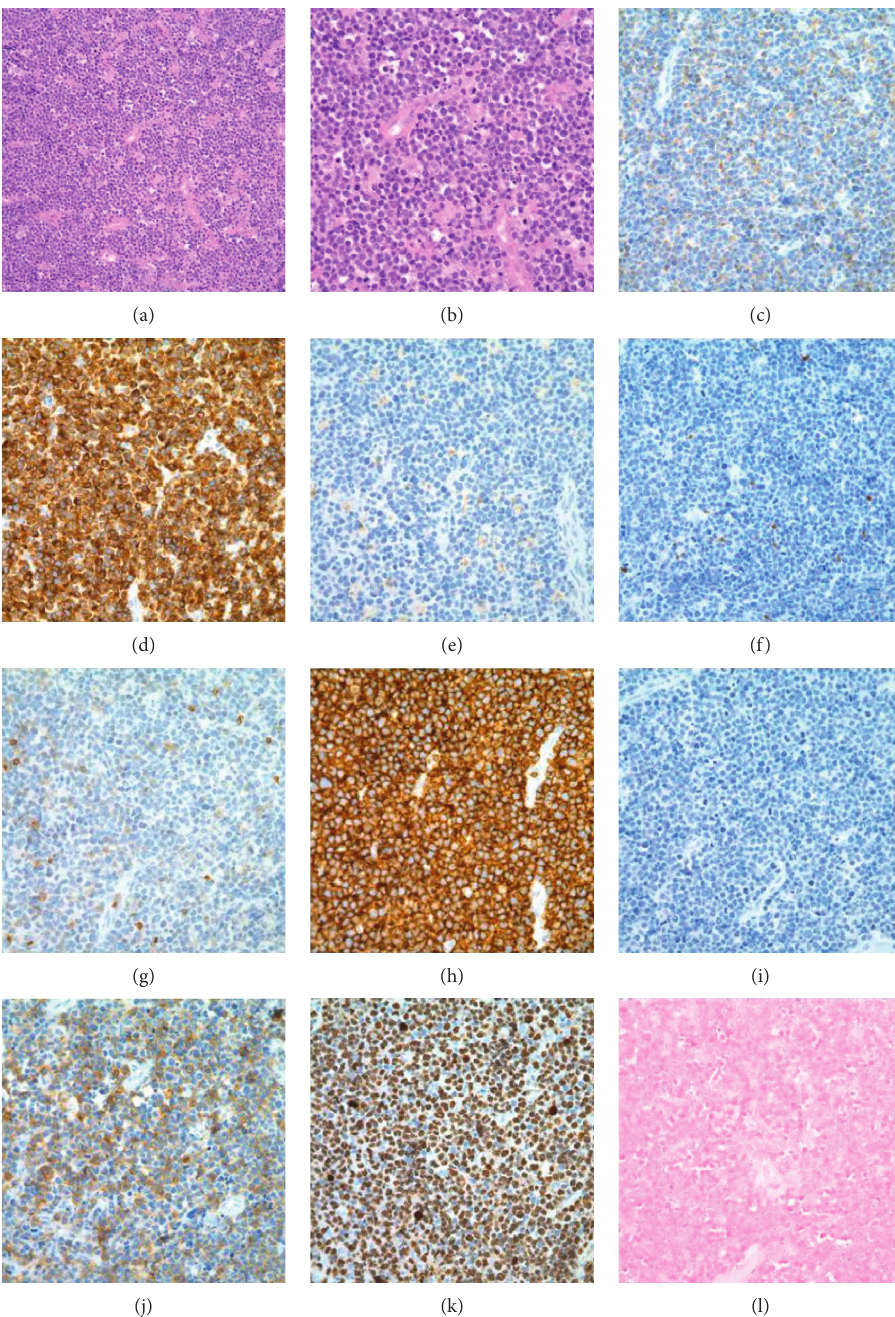
Figure 2: Biopsy of the left cervical lymph node. Hematoxylin and eosin (a, b), immunohistochemistry staining (c–j), and in situ hy- bridization (l). (a, b) H&E sections showing sheets of pleomorphic atypical medium-to-large lymphocytes. (c) CD2. (d) CD3. (e) CD4. (f) CD5. (g) CD7. (h) CD8. (i) CD20. (j) CD25. (k) Ki67. (l) Epstein–Barr virus- (EBV-) encoded RNAs (EBER) (original magnification, × 200 (a, c–l) and × 400